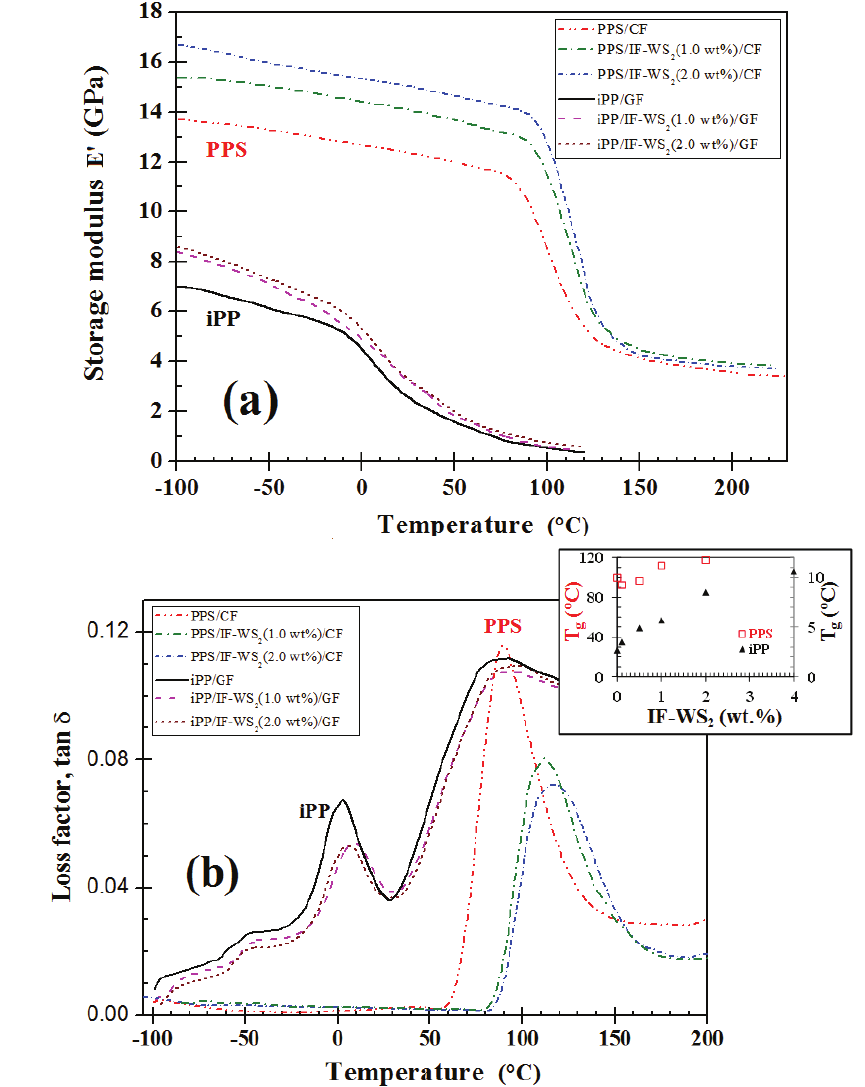
Figure 5. Evolution of the ( a ) storage modulus E' and ( b ) tan δ as a function of temperature for the neat polymers and some multiscale laminates. The inset shows the glass transition temperature T vs. IF-WS g 2